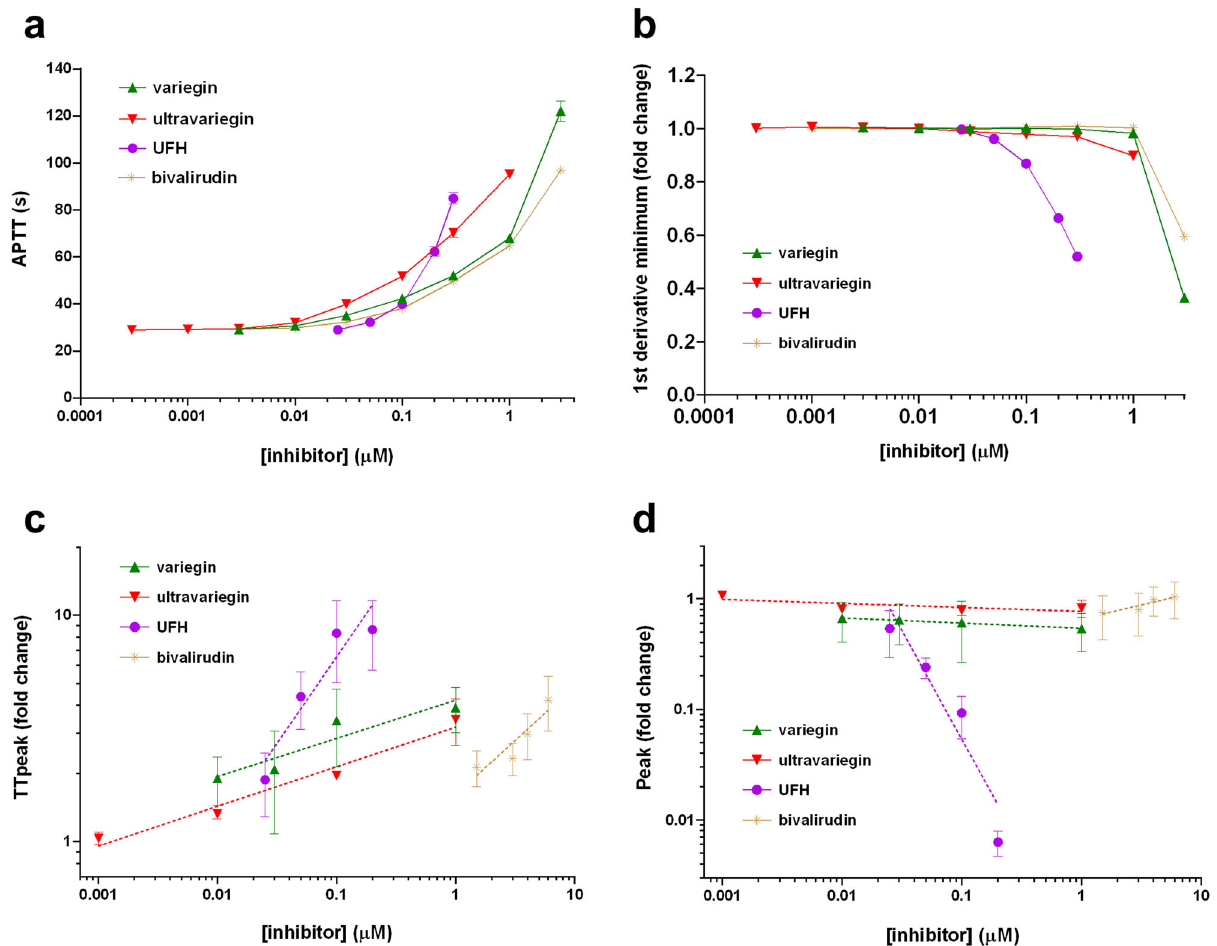
Fig. 3 Effects of variegin, ultravariegin, UFH and bivalirudin in human plasma. a APTT using PPP. b Minimum values from fi rst derivative curves using PPP. c Time-to-peak (TTpeak) and ( d ) peak thrombin concentration were plotted as fold change over vehicle controls in double logarithmic plots. The slopes of the plots indicate how fast anticoagulant intensity changed with dose and is listed in Supplementary Table 2. Experiments shown in ( c ) and ( d ) were performed in PRP in the presence of DAPT. Plots for other parameters including lag-time, endogenous thrombin potential (ETP) and velocity index (VI) can be found in Supplementary Fig. 16. Data shown are mean ± SD, n = 3 biologically independent